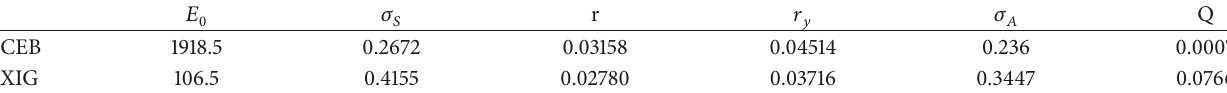
Table 3: Parameters of the CEB and XIG convertible bonds. “ 𝐸 0 ” (hundred million) stands for the equity value of the firm at issuing date, “ 𝜎 𝑠 ” the long-term mean volatility of the underlying stock before issuing date, “r” the 6-year risk-free interest rate at the issuing date, “ 𝑟 𝑦 ” the